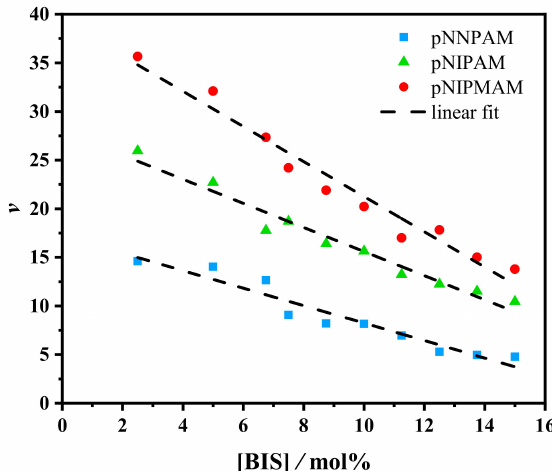
Figure 4. The Hill parameter ν vs. concentration of BIS in p(NNPAM) (blue), p(NIPAM) (green), and p(NIPMAM) (red) particles. The Hill parameter ν has been calculated with the Hill-like Equation (6) for the interaction parameter χ . The dashed lines are guides to the eye.